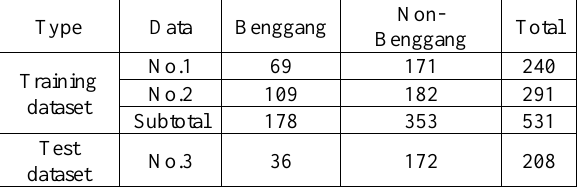
Table 1. Training dataset, Testing set and